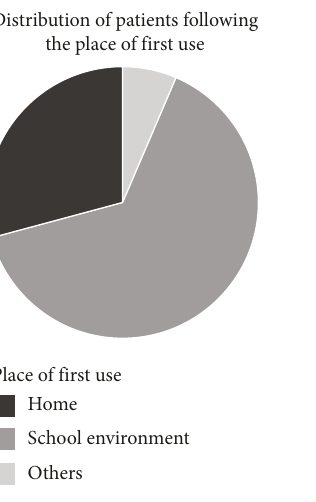
Figure 6: Distribution of the patients according to the place of the first experimentation.